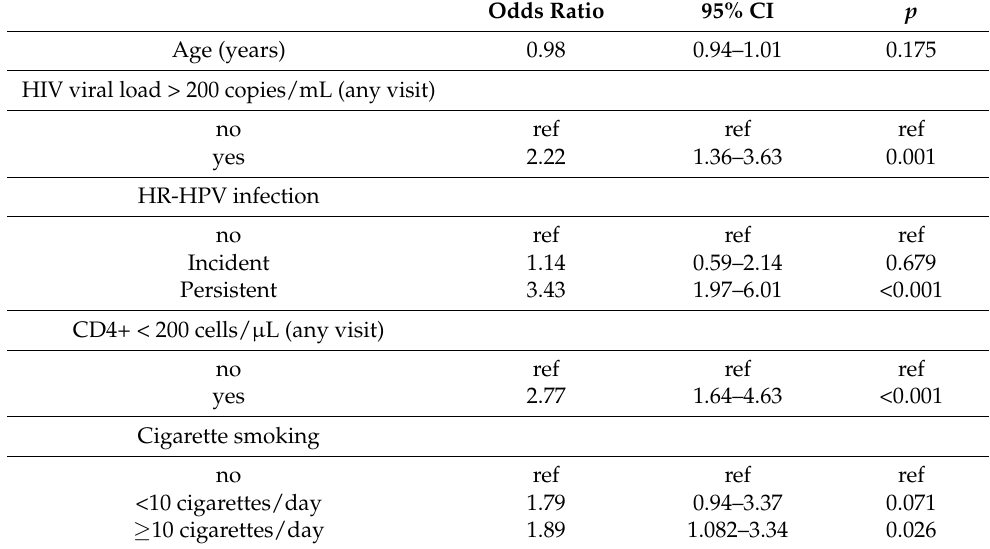
Table 3. Odds ratio (OR) and 95% confidence interval (CI) of CIN2+ development associated with age, CD4+ cell count, HIV viral copies, HR-HPV infection, and cigarette